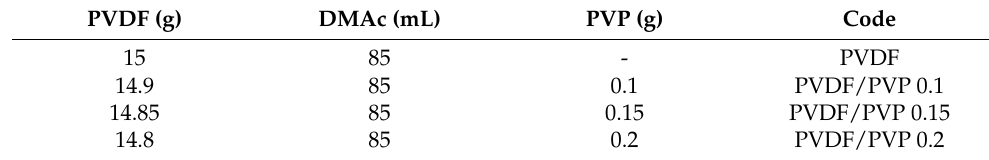
Table 1. Composition of the casting solutions. PVDF